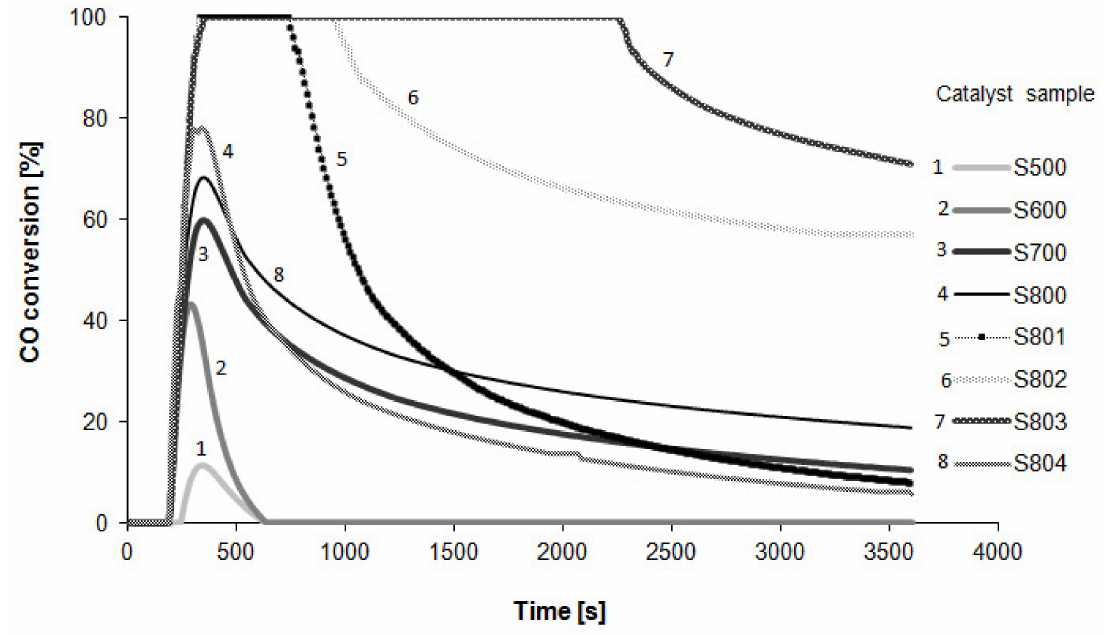
Figure 1. CO conversion at room temperature vs. time on the Pt/Al 2 O 3 catalyst sample reduced under different